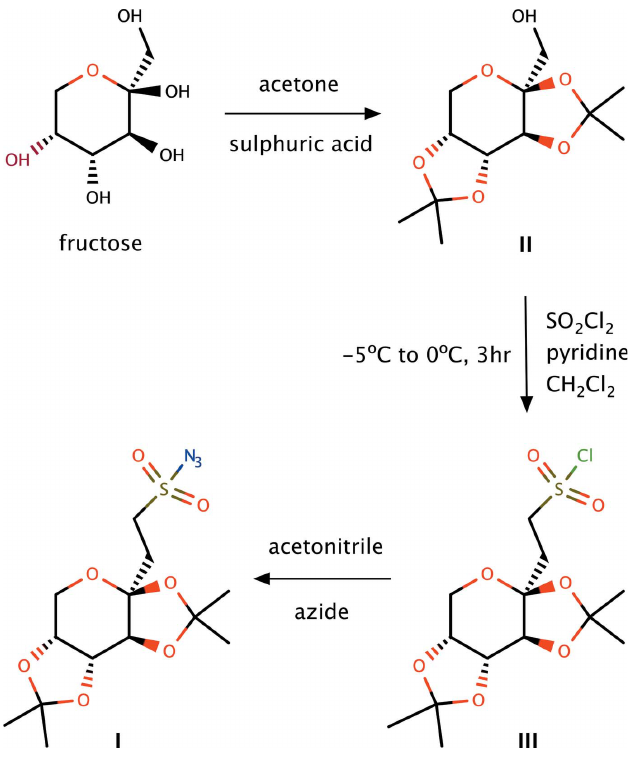
Figure 6 The reaction scheme for the synthesis of I starting from fructose.